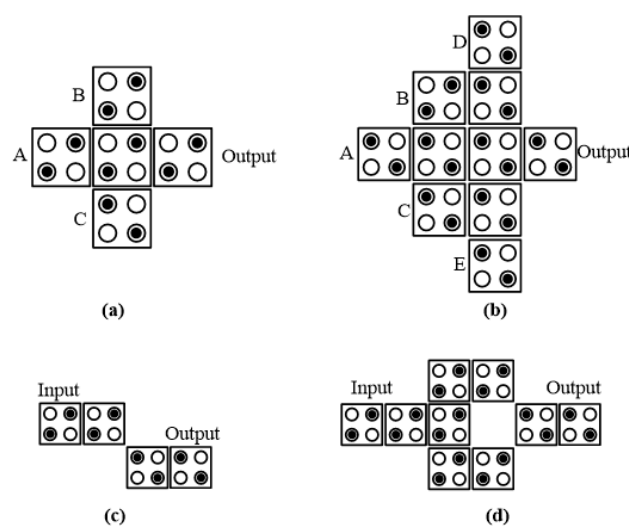
Figure 2. Quantum-dot cellular automata (QCA) basics: ( a ) wire; ( b ) three-input majority gate; ( c ) five-input majority gate; ( d ) simple inverter; and ( d ) robust inverter.